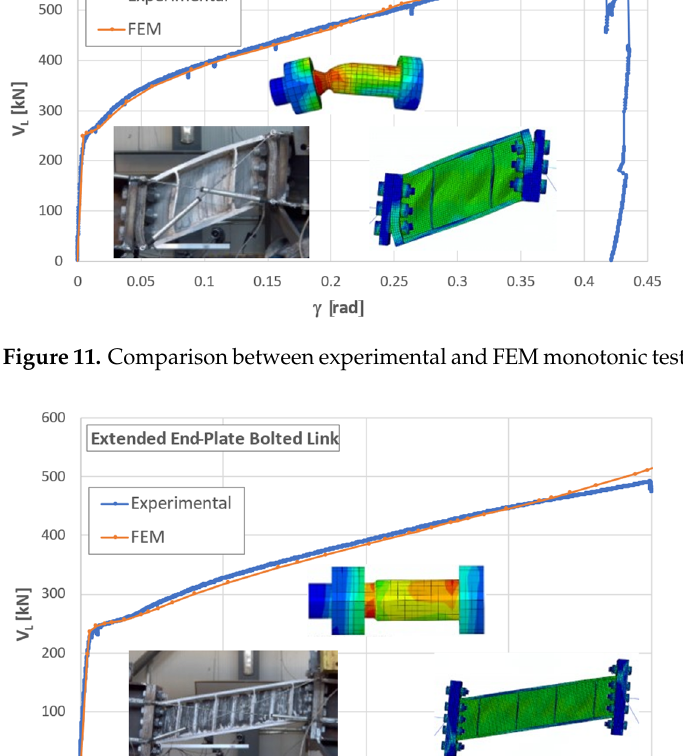
Figure 11. Comparison between experimental and FEM monotonic test of a flush end plate bolted link.